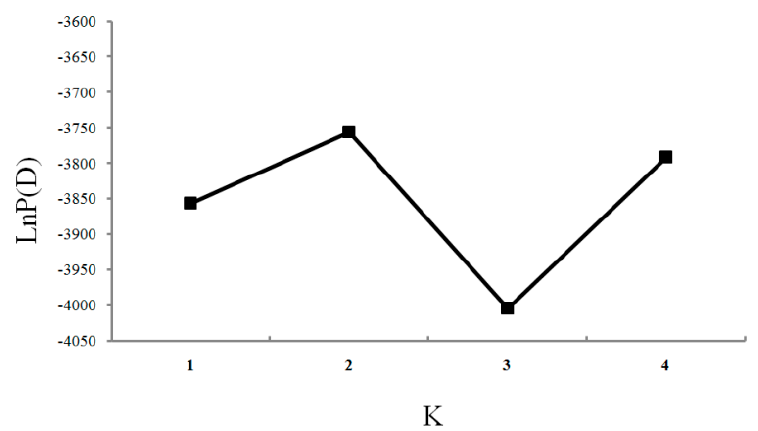
Figure 5. The model choice criterion ln P ( D ) for each K value and graphical results of the STRUCTURE